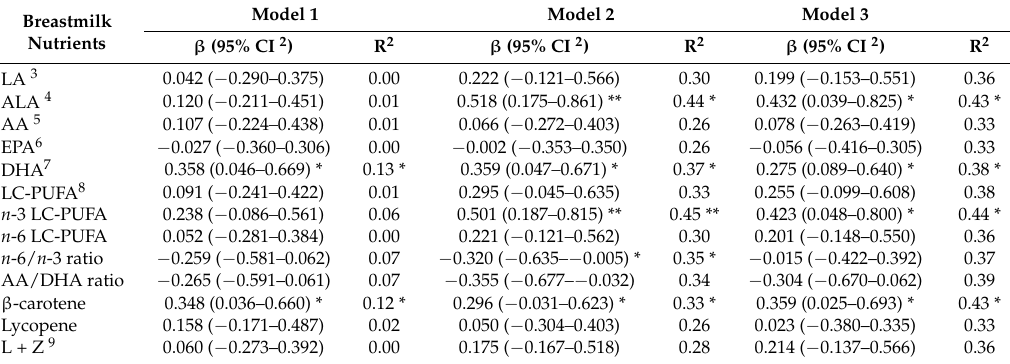
Table 5. The results of the linear regression models of the associations between breastmilk nutrients and the results of the Motor Skills DSR Performance subscale (the other subscales are presented in Supplementary Materials Table